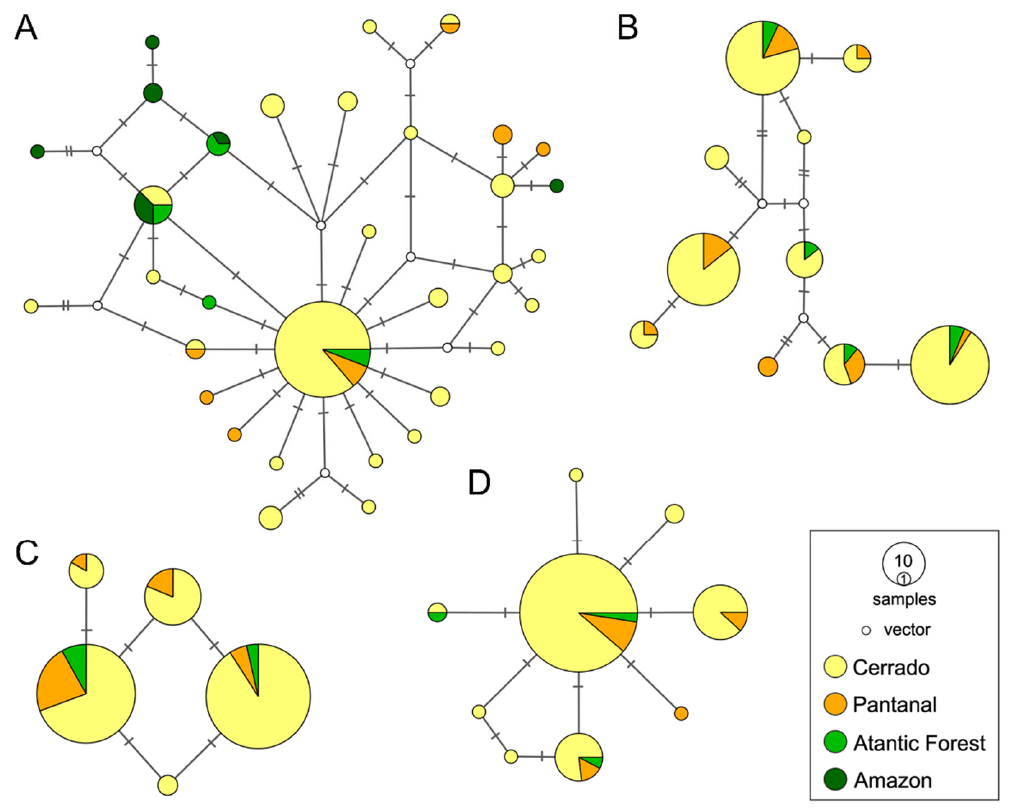
Figure 2. Median ‐ joining haplotype networks of ( A ) concatenated mtDNA, ( B ) exon 28 of VWF, ( C ) BDNF, and ( D ) RAG2. Circles represent haplotypes, colours represent biomes, and hatch marks symbolize mutations. Table 2. Summary of concatenated mtDNA diversity parameters estimated for each cluster of Myr ‐ mecophaga tridactyla . n : number of samples; H: number of haplotypes; h : haplotype diversity; π : nu ‐ cleotide diversity; SD: standard deviation.